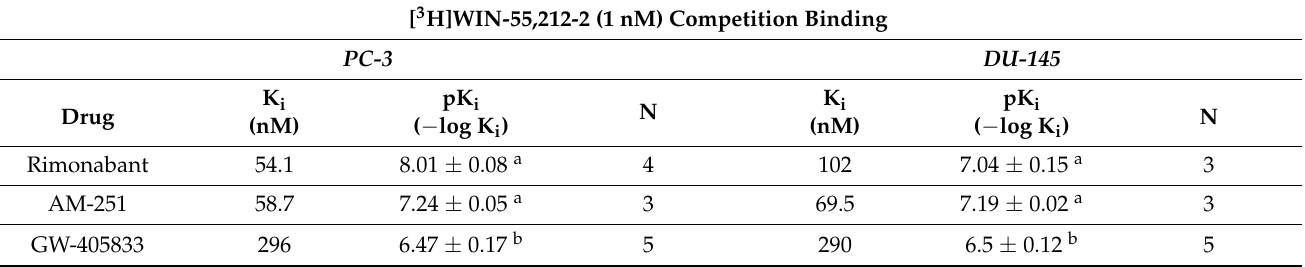
Table 1. CBR affinity (K i ) of tested compounds in PC3 and DU-145